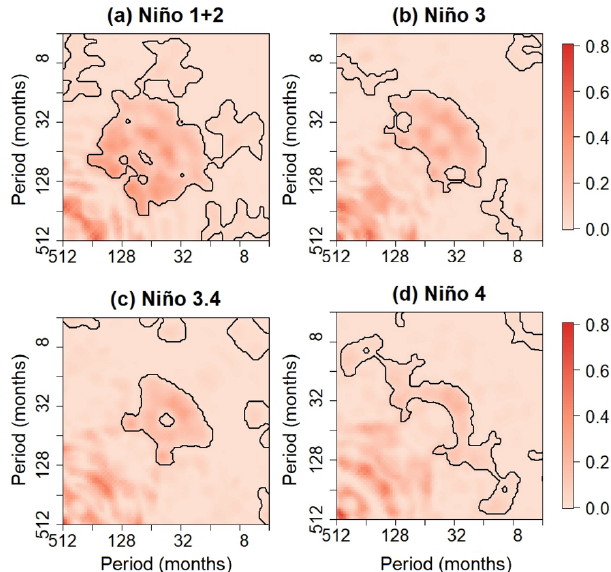
Figure 11. Global auto-bicoherence spectra of the (a) Niño 1 and 2, (b) Niño 3, (c) Niño 3.4, and (d) Niño 4 indices. Contours enclose regions of 5% cumulative area-wise